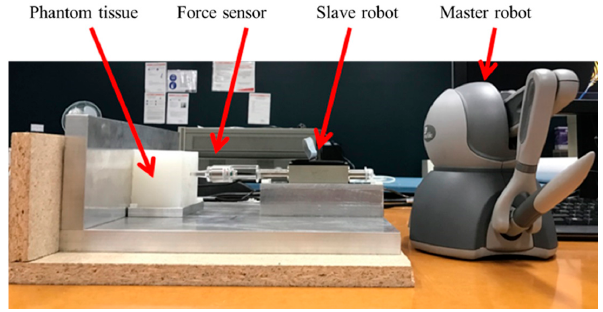
Figure 5. System configuration for robotic indentation.